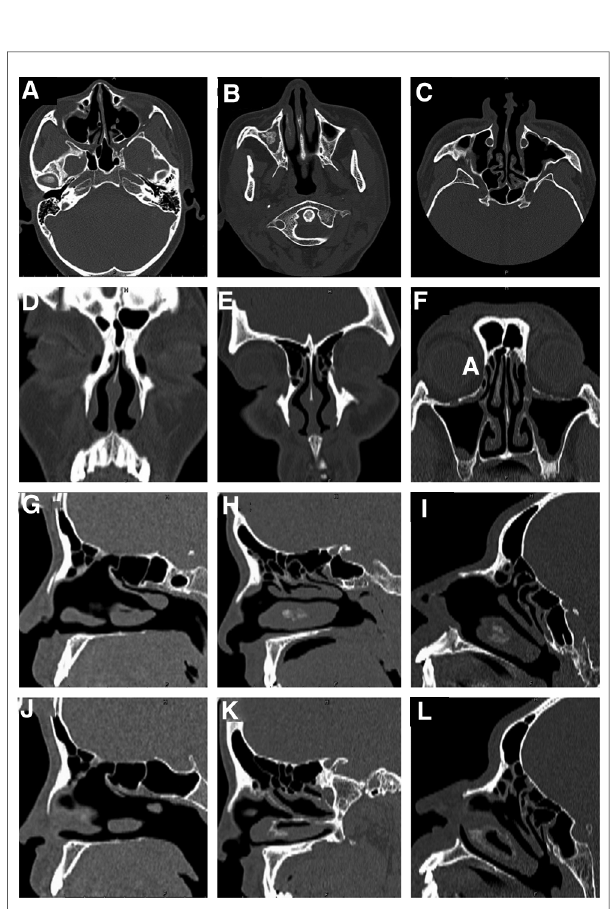
FIGURE 1 Preoperative thin slice CT examination of paranasal sinus in patients 1, 2 and 3: patients 1 ( A , D , G , J ), 2 ( B , E , H , K ), 3 ( C , F , I , L ), horizontal ( A – C ), coronal ( D – F ), and sagittal left ( G – I ) and right ( J – L